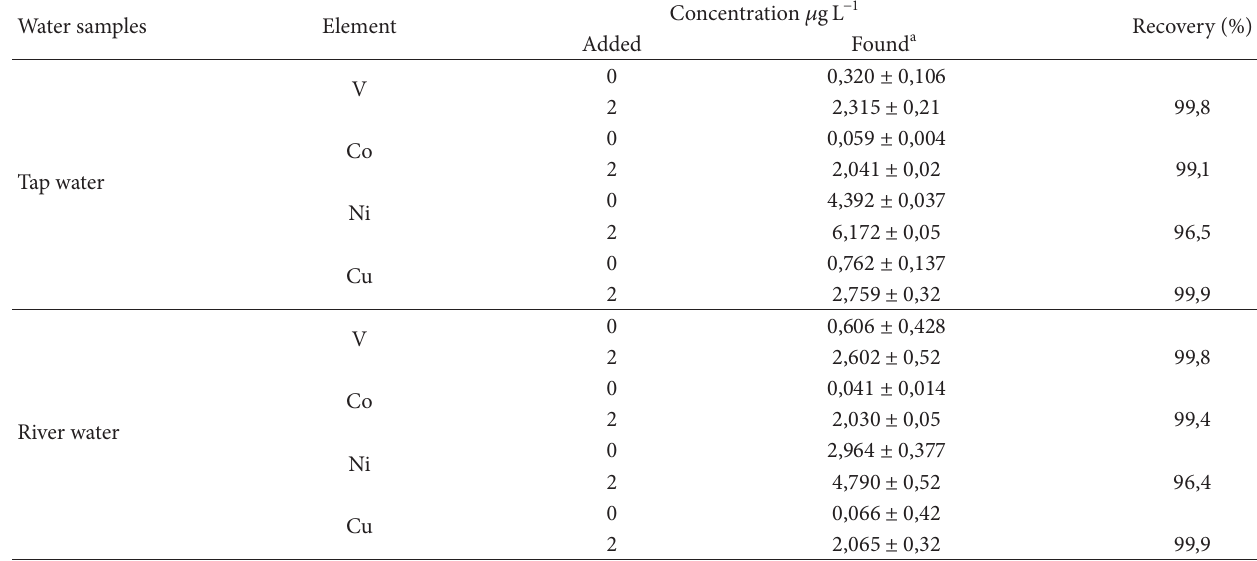
Table 11: Simultaneous determination of metals in natural water samples by ICP-MS at pH 4.